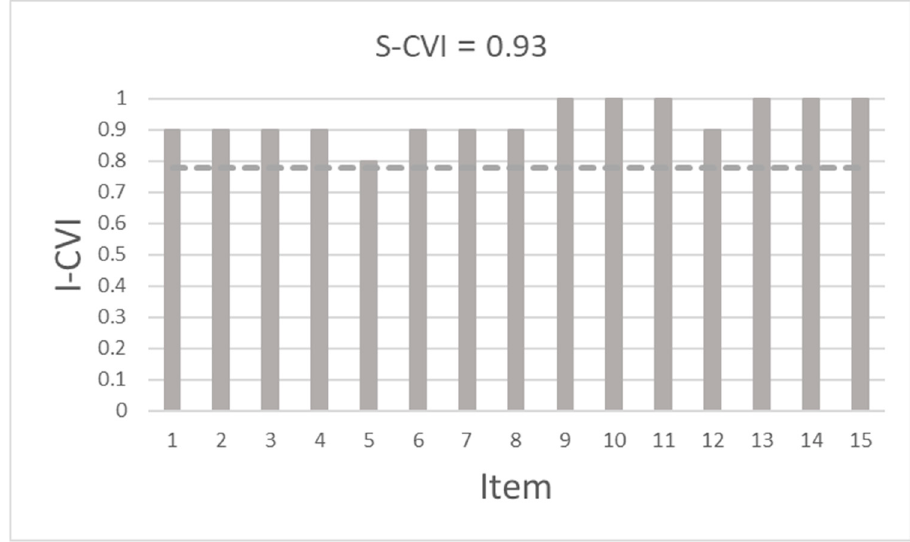
Figure 2. Content Validity Index of individual items (I-CVI) and the overall scale (S-CVI).